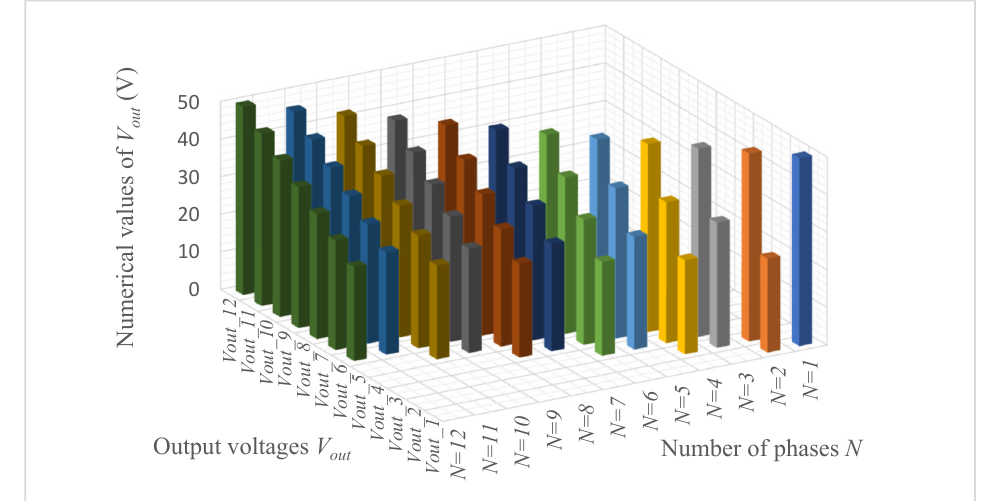
Figure 5. Output voltage values with zero-current ripple corresponding to certain duty cycles at different numbers of phases of interleaved DC–DC converter.